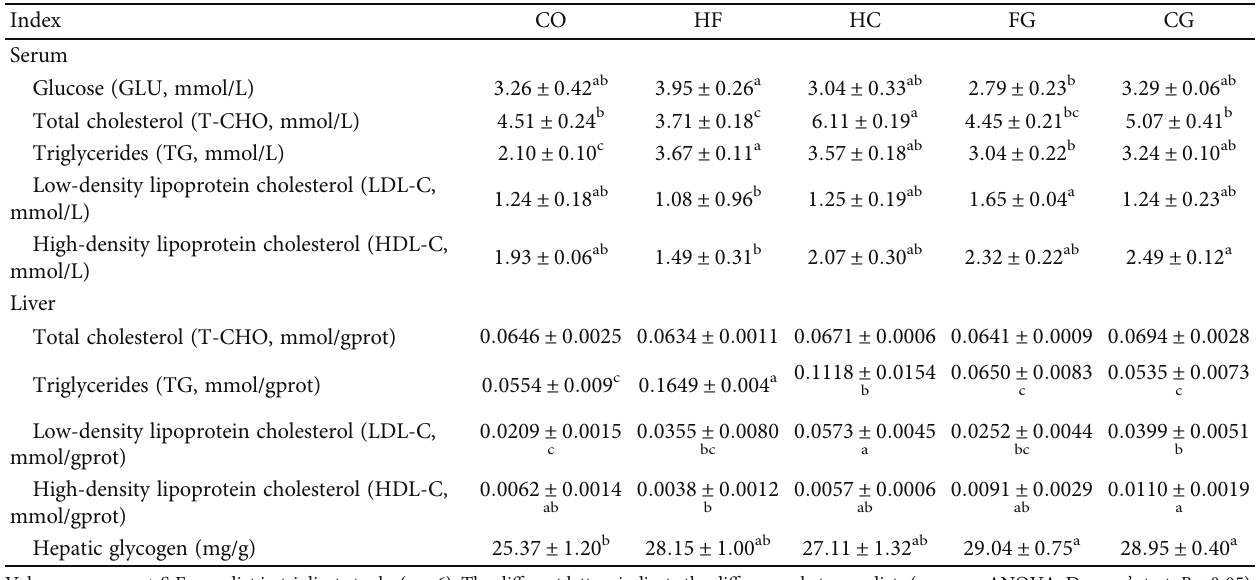
Table 5: Serum and liver biochemical indicators of common carp fed di ff erent experimental